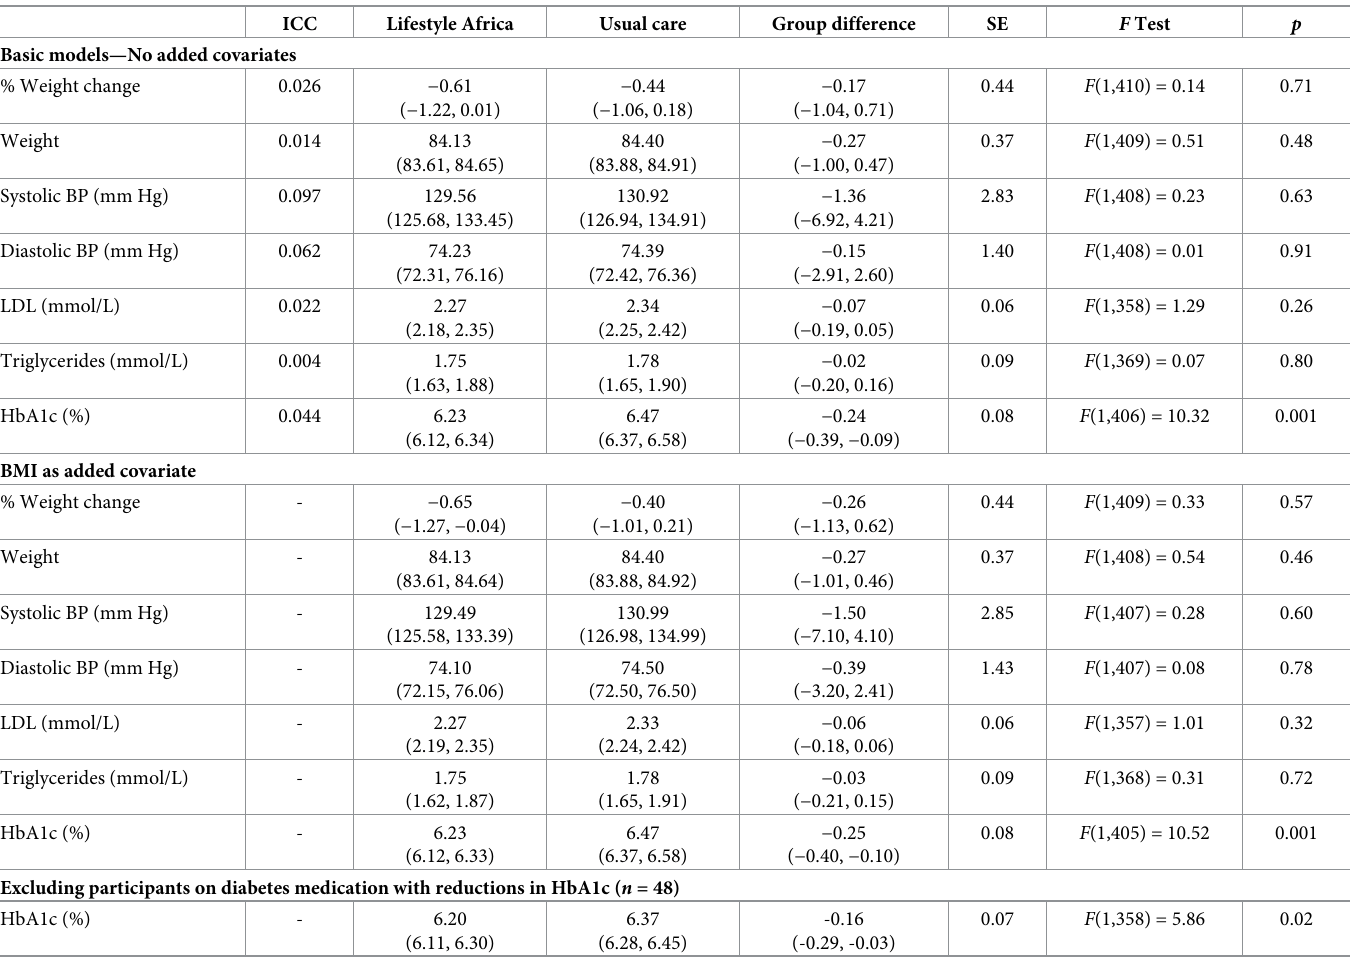
Table 3. ANCOVA model summaries for each outcome.